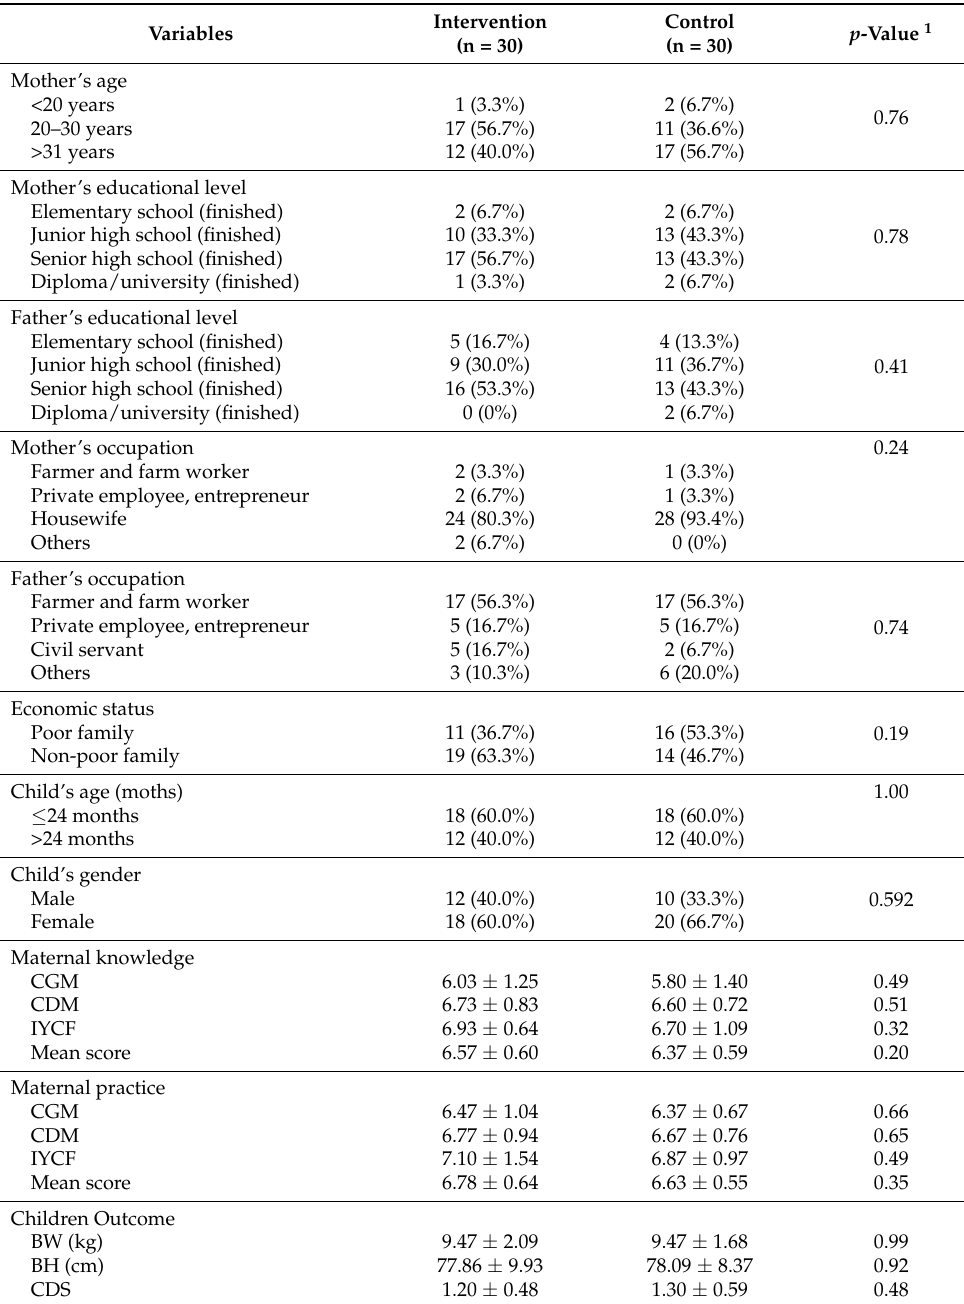
Table 1. Maternal and children characteristics by treatment